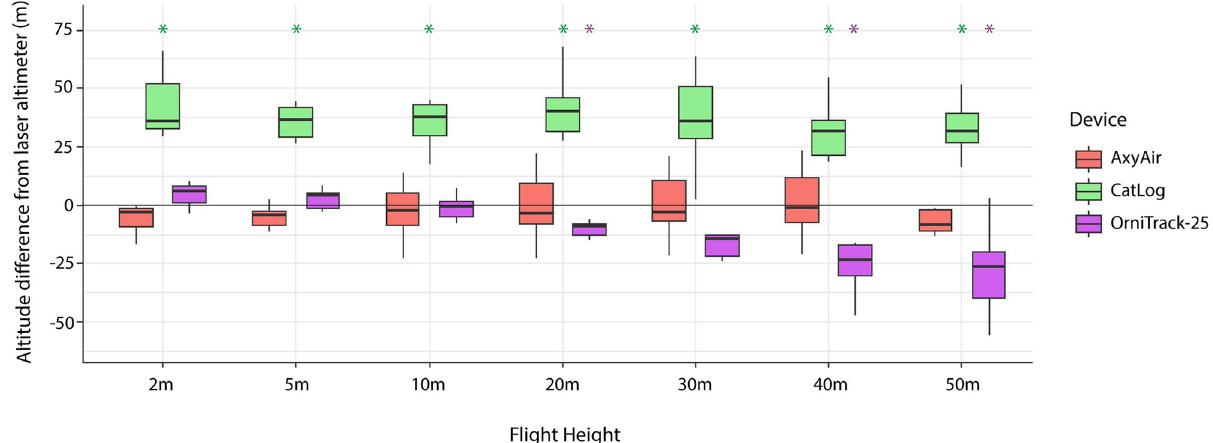
Fig 3. Mean difference in altitude estimates between each device and the laser altimeter measurement for the seven flight heights tested during stationary estimates. Asterisks represent significant differences from the laser altimeter measurement ( α = 0.05). The black horizontal line represents zero, or no difference between the altitude estimate of the device and the measurement from the laser altimeter. As the mean difference from laser altimeter did not improve with HDOP < 2, we did not include this data in this figure.